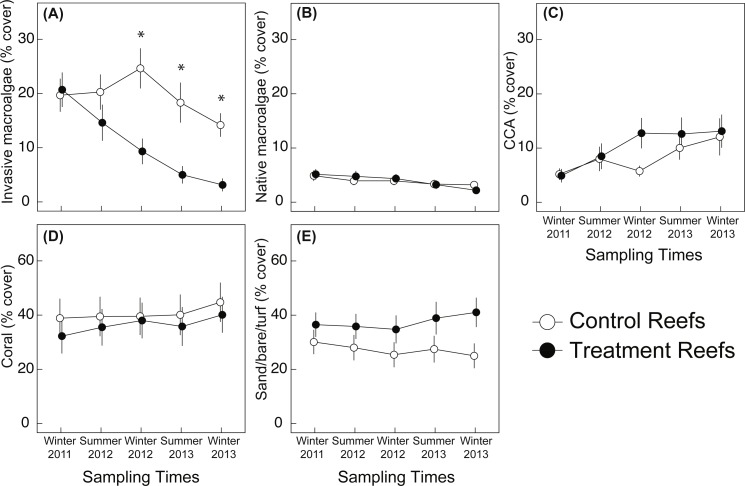
Mean percent cover of benthic cover types.(A) combined invasive macroalgae (Eucheuma clade E/Kappaphycus Clade B/Acanthophora spicifera/Gracilaria salicornia), (B) native macroalgae, (C) crustose coralline algae (CCA), (D) corals, and (E) SBT (sand/bare/turf). Values are mean ± SE; n = 24 (control) and n = 26–27 (treatment) for each sampling time. The first time point in each figure (Winter 2011) represents the “before” time period of the study and all subsequent time points represent the “after” period. Symbols (*) represent a significant difference (p ≤ 0.05) between the control and treatment.